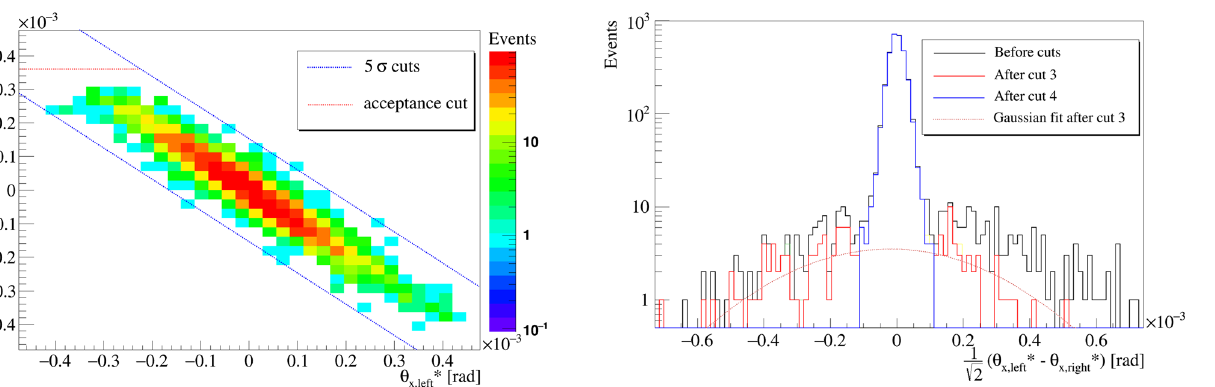
Fig. 2 The collinearity cut of the two protons using the horizontal scattering angle θ ∗ x . The red and blue lines show the acceptance and 5 σ physics cuts, respectively Table 1 The physics analysis cuts and their width σ in Diagonal 1 (the otherdiagonalisinagreementwithinthequoteduncertainty).Thewidth σ of the horizontal and vertical collinearity cuts define the resolution in the scattering angle, see Fig. 2